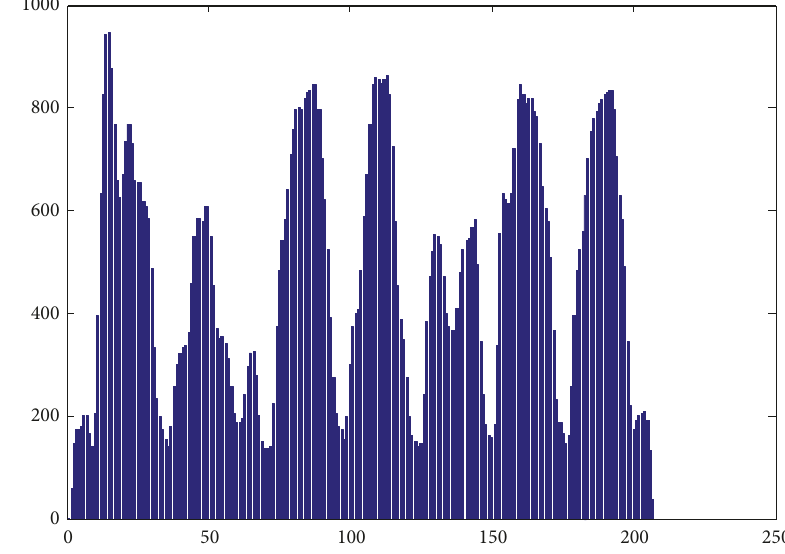
Figure 6: Histogram of vertical integral